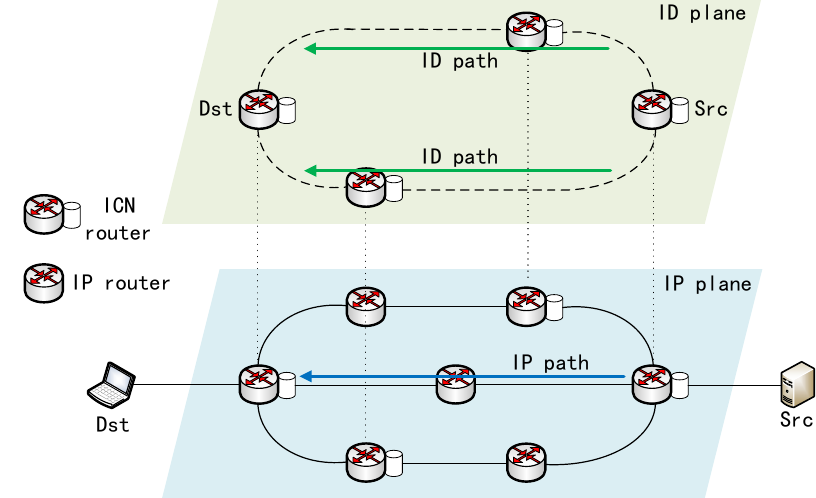
Figure 1. The principle of the multipath transmission method in ICN.